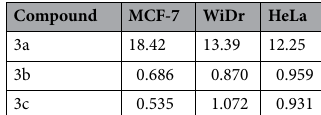
Table 3. Selectivity index of hydroxyxanthone derivatives as anticancer agent.